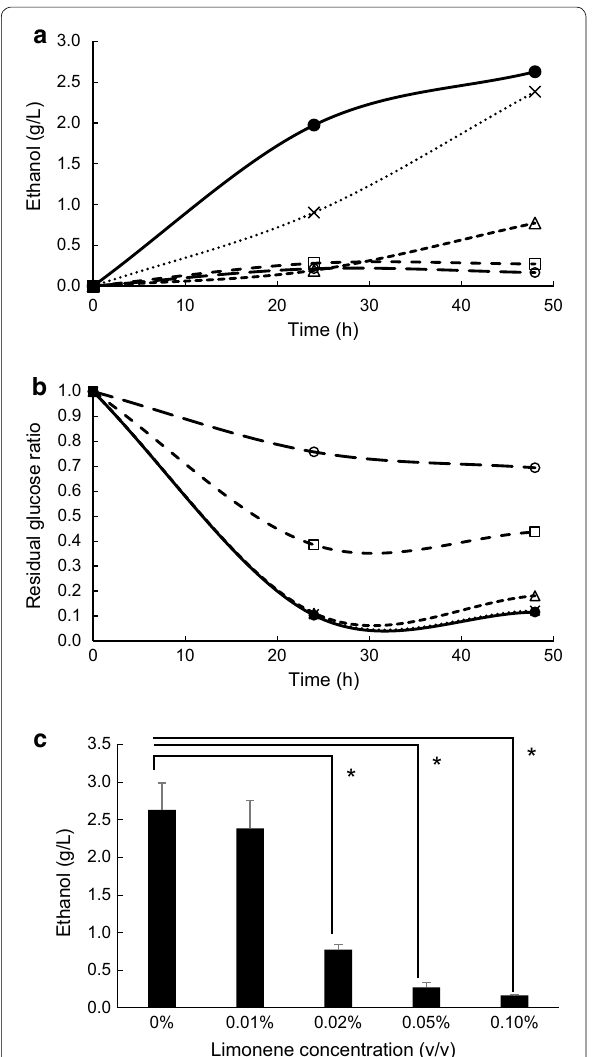
IBE fermentation by C. beijerinckii from the culture supernatant with C. cellulovorans